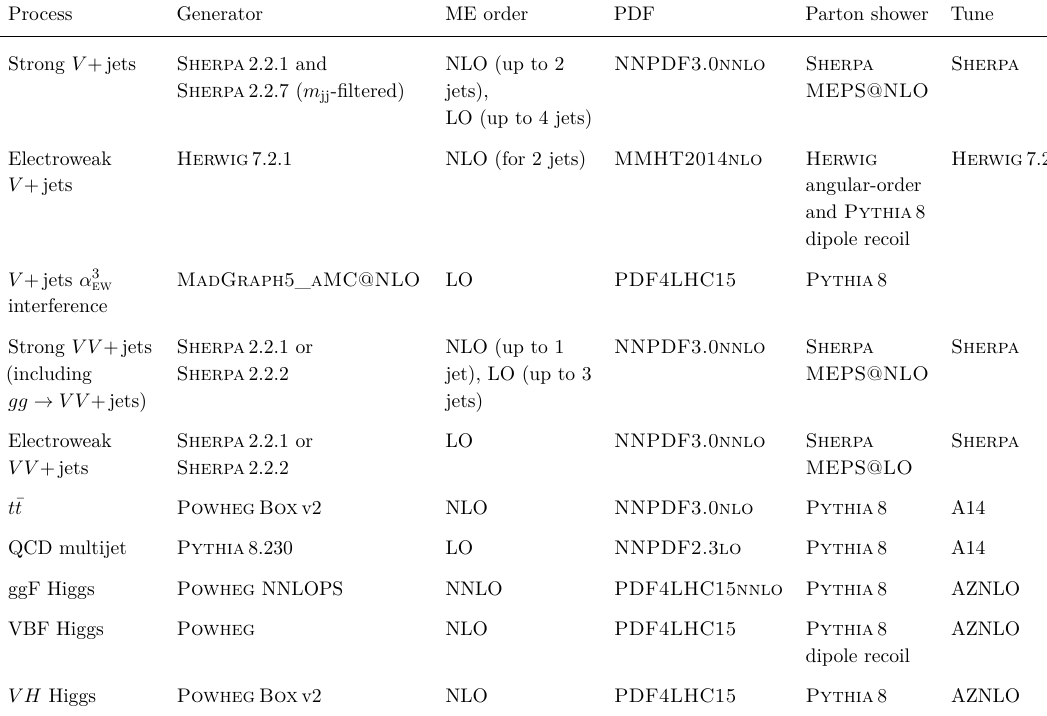
Table 1. Summary of generators used for simulation. The details and the corresponding references are provided in the body of the